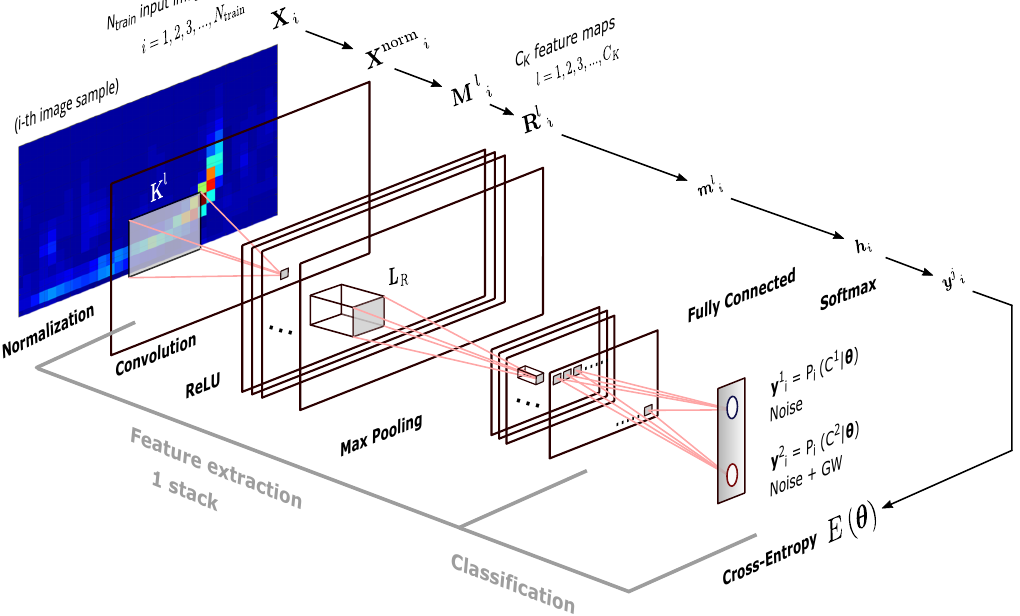
Figure 5. Single stack CNN architecture used as basis for this research. N train same size image samples are simultaneously inputted, but, for simplicity, we detail the procedure for a single image—besides, although this image is shown colorized, training images dataset occupies just one channel. A X i image feed the CNN, and a two-dimensional vector is outputted, giving us posterior probabilities of class 1 (noise alone) and class 2 (noise + GW), both being conditioned by model parameters included in vector θ . After that, cross-entropy E ( θ ) is computed. The notation for input(output) matrices and vectors is the same as that introduced in Section 2.5 to mathematically describe the several kinds of layers that are used in the